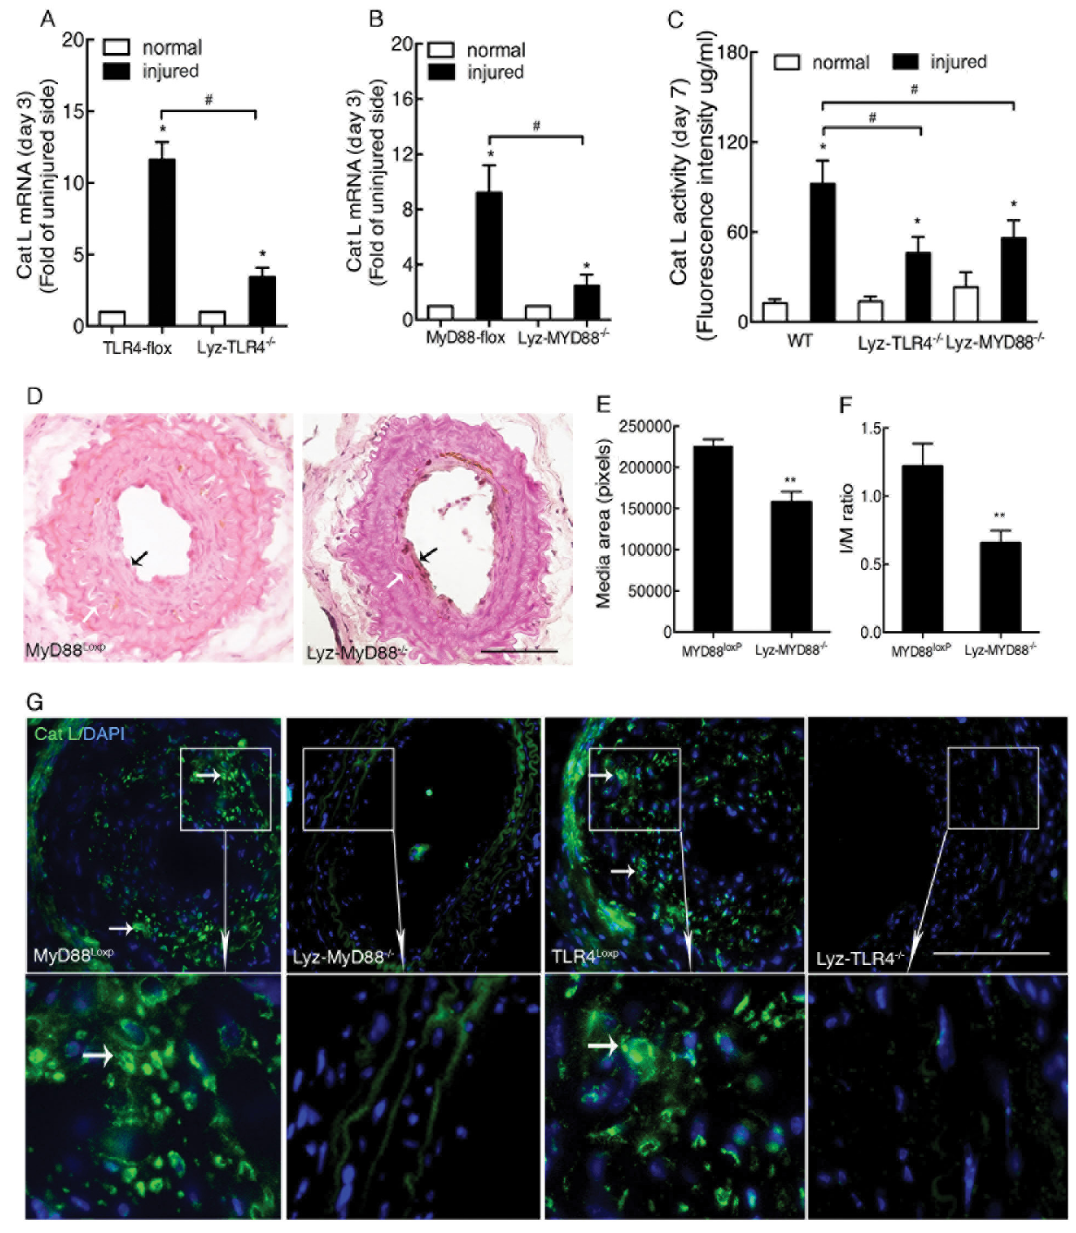
Figure 2. TLR4- MyD88 signaling in macrophage may regulate cathepsin L activity and vascular remodeling. Common carotid arteries were injured by a 0.4 mm guide wire plus external carotid artery ligation. (A,B) Arterial mRNA levels for cathepsin L was measured by reverse transcription polymerase chain reaction and normalized to 18S transcript levels 3 d following wire injury. Relative mRNA levels compared with the uninjured carotid artery are displayed (n = 4–6). (C) Arterial enzyme activity for cathepsin L was measured by a fluorescence-based assay and normalized to tissue extract protein concentration at d 7 following wire injury. Cathepsin L activity of the injured and uninjured carotid arteries from wild-type, Lyz-TLR4 -/- and Lyz-MyD88 -/- mice are displayed (n = 4 at each time point). (D–F) Representative hematoxylin and eosin stained sections of carotid arteries from MyD88 l ° xp/ L° xp mice (n = 6) and Lyz-MyD88 -/- mice (n = 8) are shown. The ratios of intima and media area and vessel medial size were quantified by planimetry at 28 d. The white arrows indicate internal elastic lamina. The black arrows indicate luminal side of the artery . (G) Carotid arteries at 28 d after injury that were immunostained for mouse cathepsin L. The arrows indicate cells stained positive for cathepsin L. Representative hematoxylin and eosin stained and immunofluorescent-stained sections are shown. Data represent the means ± SEM. * P <0.05, ** P <0.01 versus respectively controls. Scale bar represents 100 μ